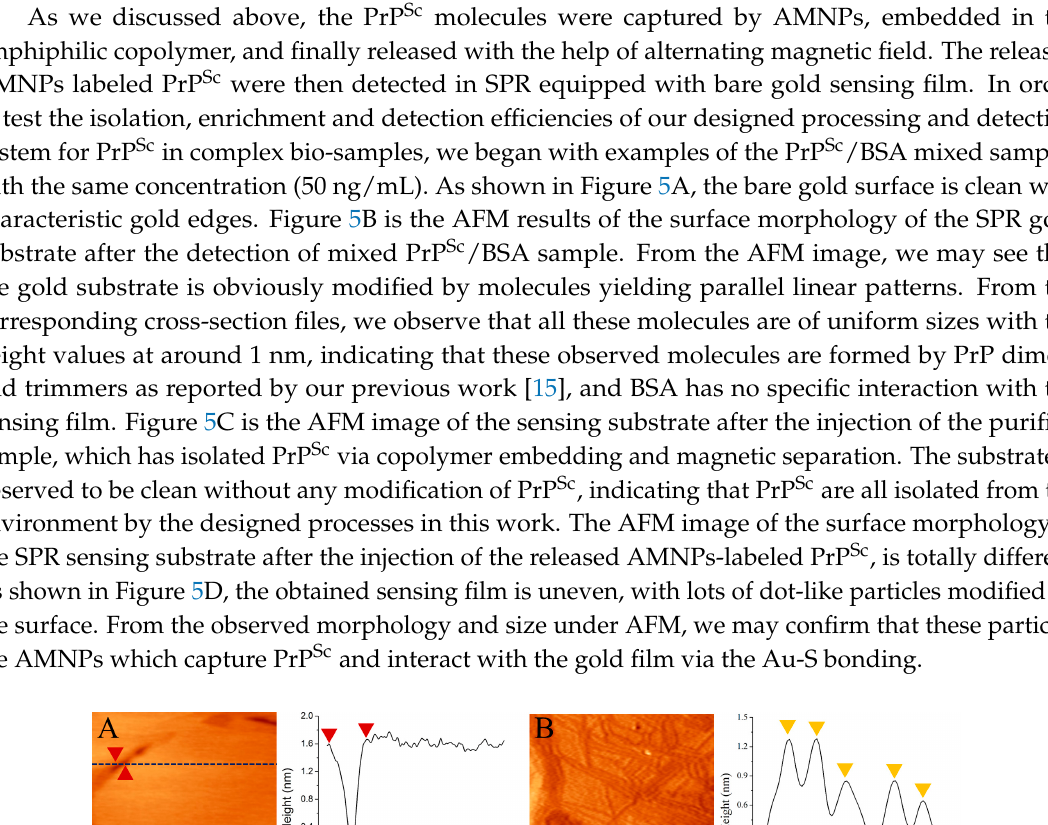
Figure 6. ( A ) The SPR detection signals of the treated (red), untreated (blue) and the purified (black) samples. Insert: Schematics of the SPR detections. ( B ) SPR sensorgram and ( C ) calibration curve of the SPR detection assay for PrP Sc at different concentrations.